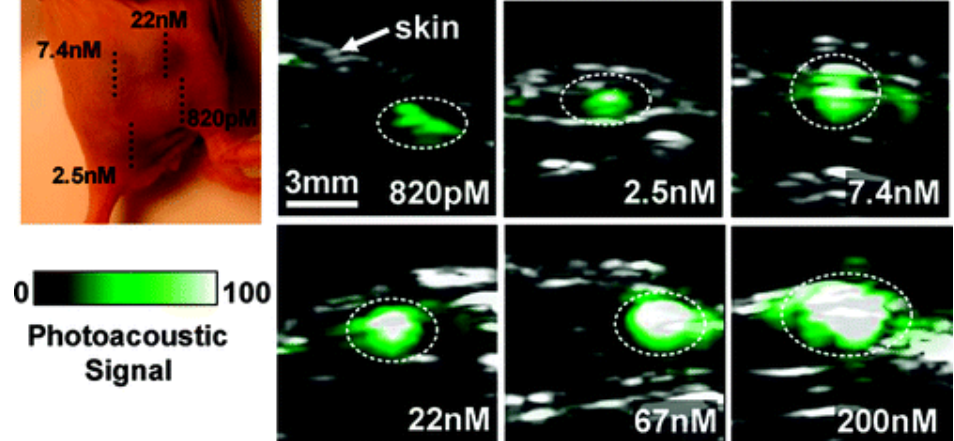
Figure 3. Photoacoustic detection of SWNT-ICG in living mice. Mice were injected subcutaneously with SWNT-ICG at concentrations of 0.82–200 nM. The images represent ultrasound (gray) and photoacoustic (green) vertical slices through the subcutaneous injections (dotted black line). The skin is visualized in the ultrasound images, while the photoacoustic images show the SWNT-ICG distribution. The white dotted lines on the images illustrate the approximate edges of each inclusion. The photoacoustic signal from each inclusion was calculated using 3D regions of interest and the “background” represents the endogenous signal measured from tissues. The error bars represent standard error (n) 3 mice). Linear regression (R2) 0.97) of the photoacoustic signal curve estimates that a concentration of 170 pM of SWNT-ICG will give the equivalent background signal of tissues. Reprinted with permission from [48], American Chemical Society, 2010.